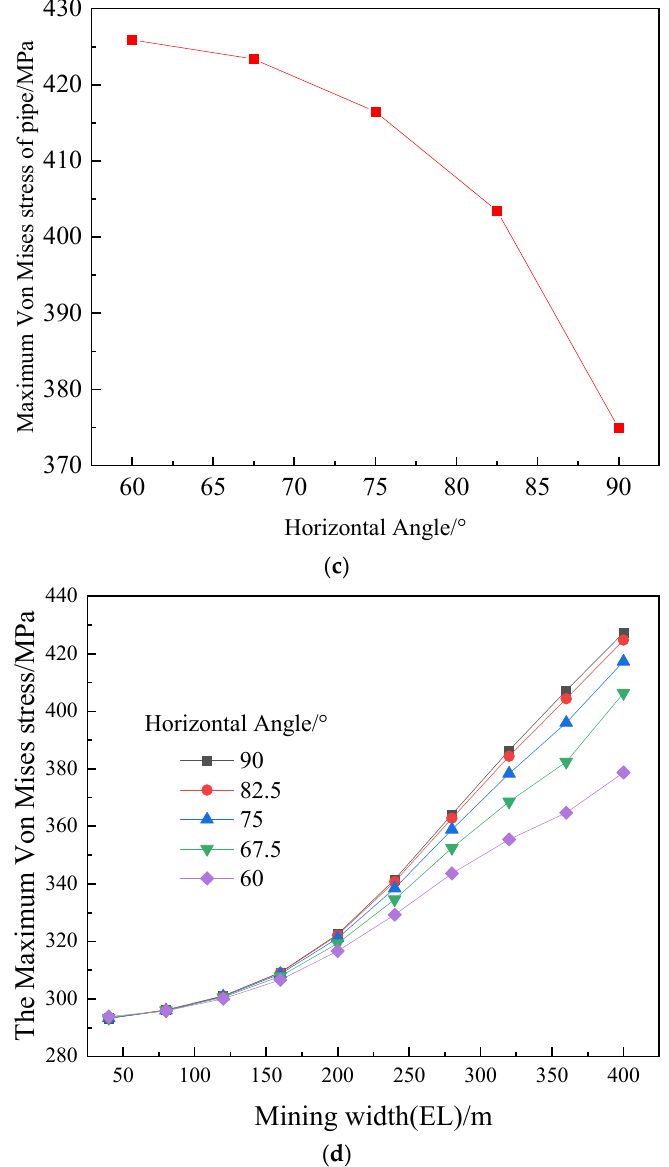
Figure 6. Equivalent stress distributions of the pipeline at di ff erent horizontal included angles. ( a ) Stress nephogram of the goaf pipeline. ( b ) Curve of the equivalent stress change of the pipeline after mining. ( c ) Curve of the maximum equivalent stress of the pipeline. ( d ) Maximum equivalent stress of the pipeline for di ff erent mining lengths.